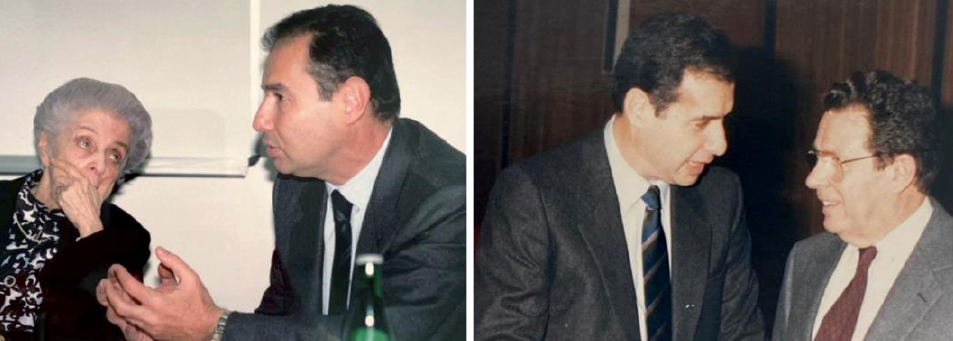
Figure 1. Francesco della Valle in the 1990s during brainstorming with his main scientific mentors, namely Rita Levi Montalcini ( left ) and Erminio Costa ( right ).